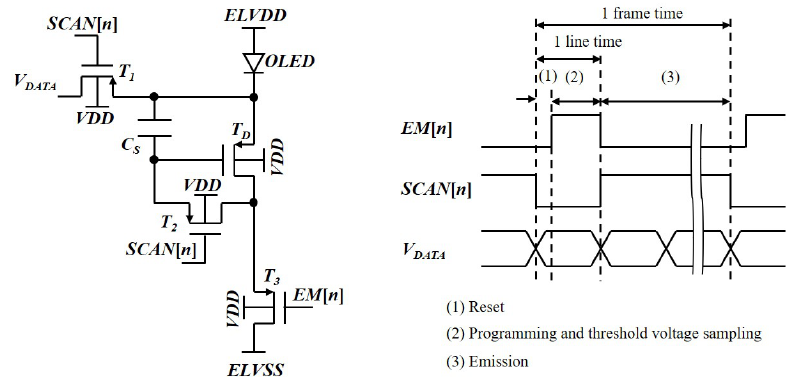
Figure 5. PMOS transistor version of 4T1C pixel circuit and timing diagram.